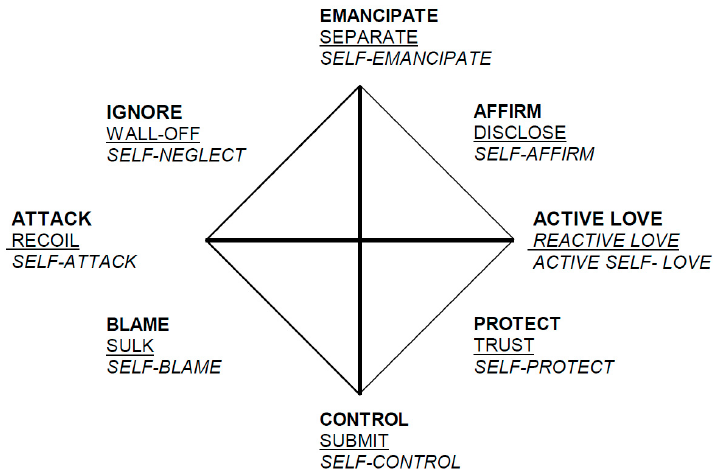
Figure 1. Simplified cluster version of the Structural Analysis of Social Behavior (SASB-model). From Benjamin [37] Guilford Press, reproduced by permission. Copyright Guilford Press.